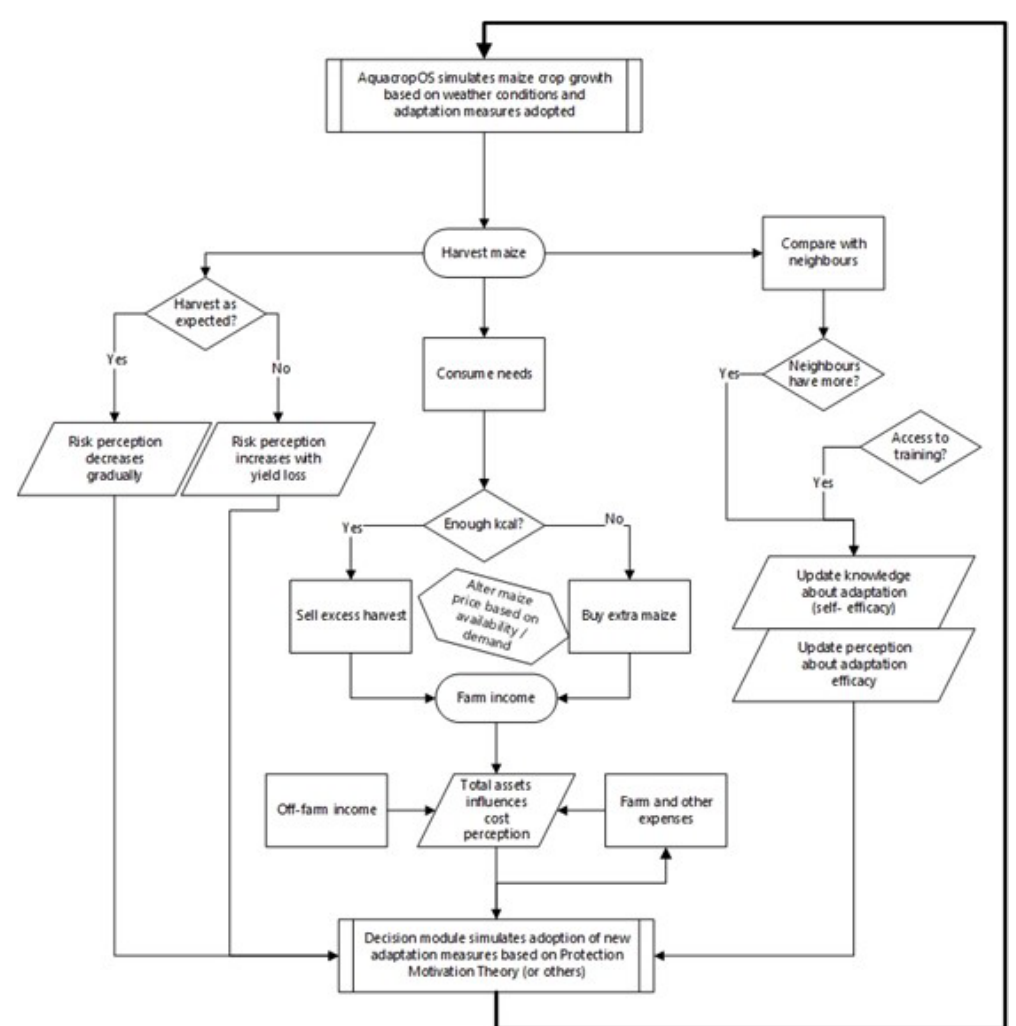
Figure A2. Flowchart showing process